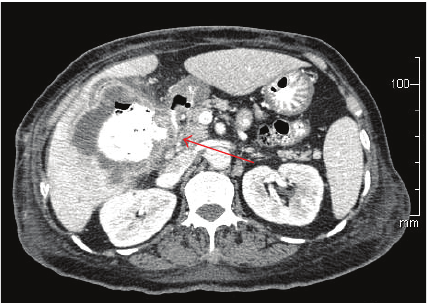
Figure 4: SCC of the gallbladder with fistula to the